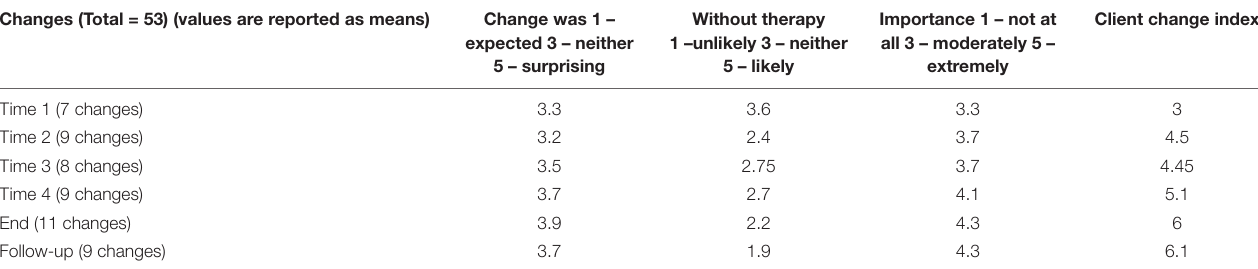
TABLE 3 | Change along therapy as rated by John in Client Change Interviews. Changes (Total = 53) (values are reported as means)